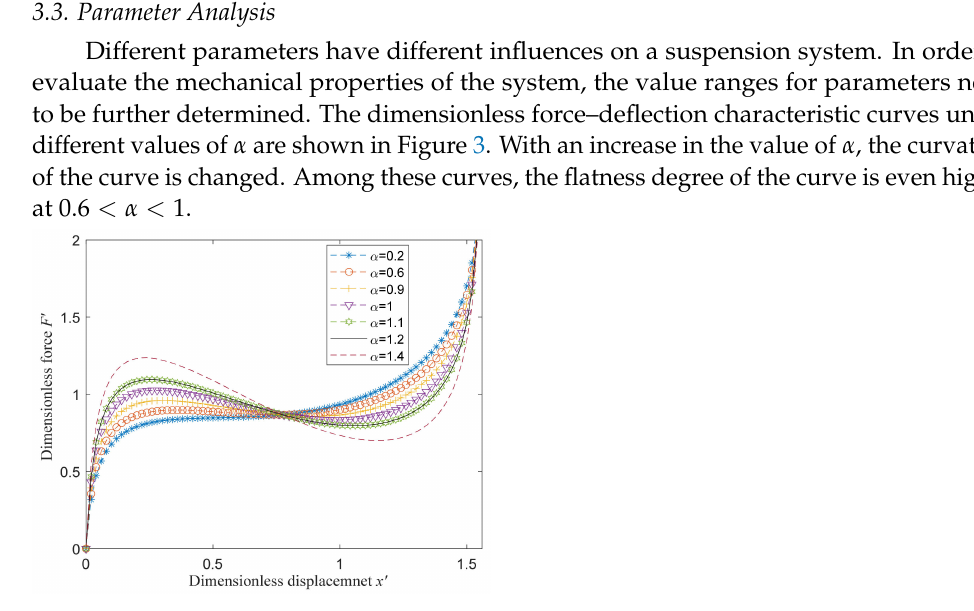
Figure 3. Dimensionless force–deflection curves with various values of α ( γ 1 = 0.8, γ 2 = 1.2, η =